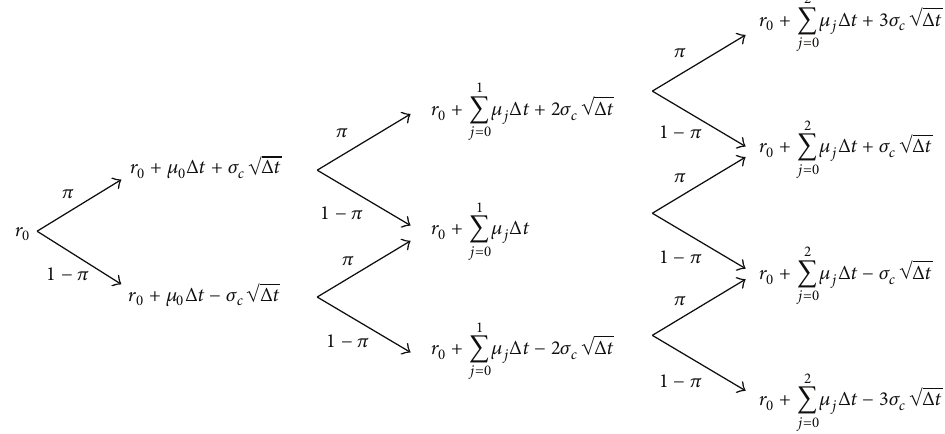
Figure 1: 4-period constant volatility interest rates binary